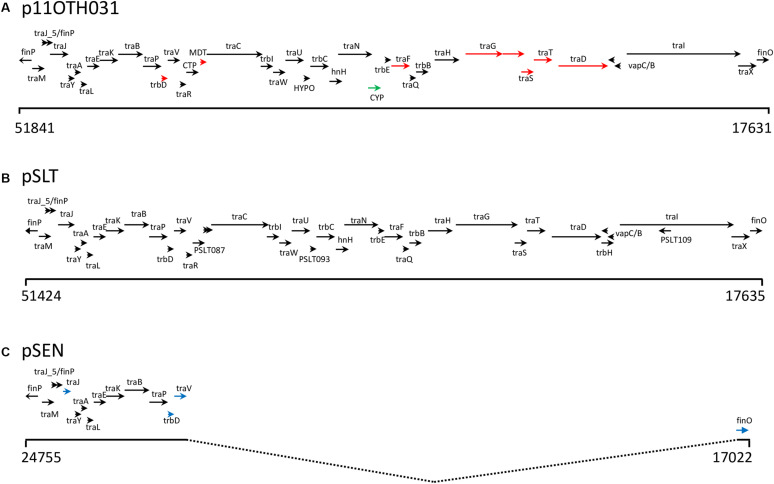
(A) Schematic showing the genes encoded by a 34.5 Kb region of p11OTH031 including the 28 Kb insertion harboring multiple genes of the incF operon. Base positions corresponding to the start and end of this region are indicated; the arrows show most of the operon transcripts running off the reverse strand. The corresponding regions of the pSLT (B) and pSEN (C) reference plasmids are also shown. Black arrows indicate similar gene lengths between all three plasmids. Red arrows indicate a different length for p11OTH031 while blue arrows indicate gene lengths specific for pSEN. The green arrow in p11OTH031 identifies a distinct gene encoding a cytosine permease not found in either pSLT or pSEN. All six S. Enteritidis plasmids analyzed in detail in this report exhibited very similar gene organization over this region with the following exceptions. The p06D1274 plasmid had a truncated traI; p08OTH027 had a truncated cytosine permease gene and a truncated traD gene while the other samples exhibited small variations in the length of the traD gene.